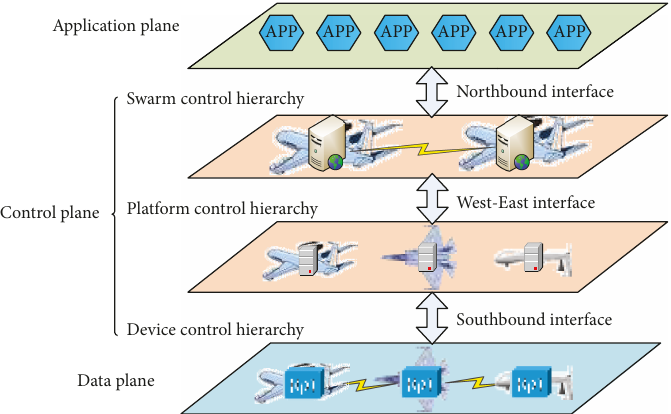
Figure 1: The SD-ATN